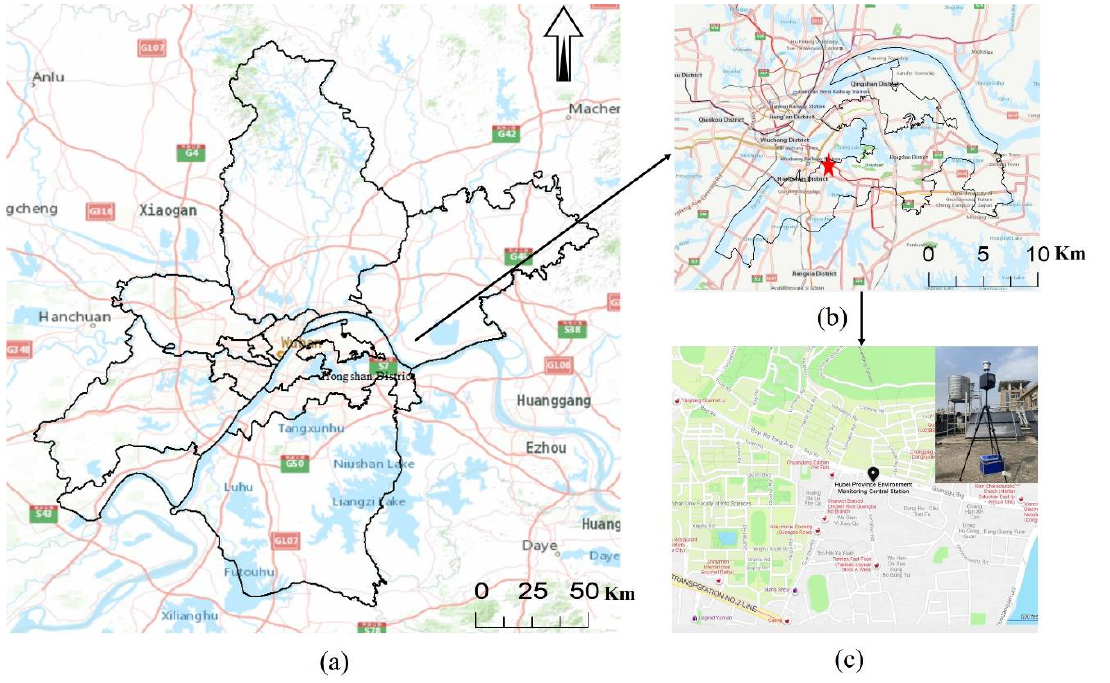
Figure 1. Sampling point locations (( a ) represents Wuhan city; ( b ) represents Hongshan District; ( c ) represents the sampling site.)